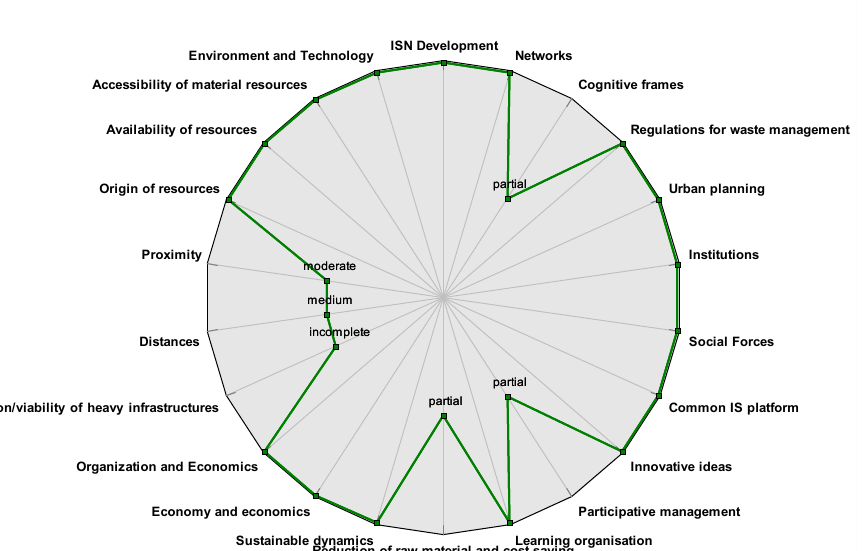
Figure 5. Polar chart of the selected attributes for ISN in Barceloneta.